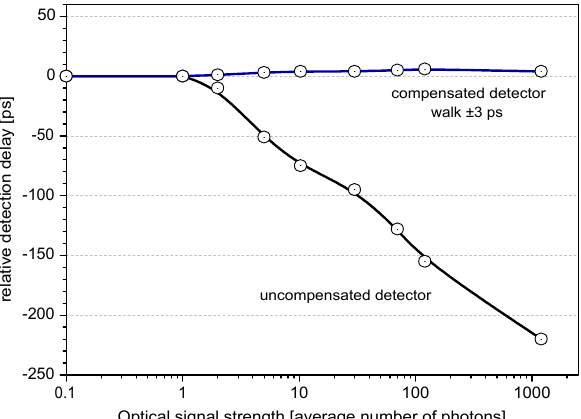
Figure 14. Detection delay of compensated (C-SPAD) [7] and uncompensated SPAD dependence on number of incident photons. The core of ground-segments of many photon-counting space